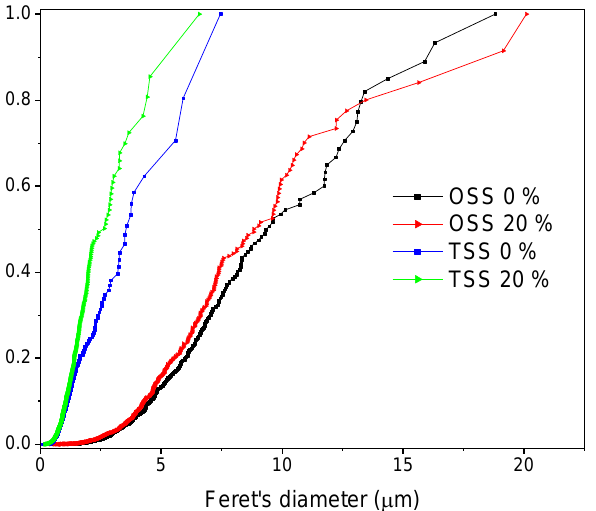
Figure 5. Cumulative volume grain size distribution versus Feret’s diameter of sintered samples with different waste alumina content.